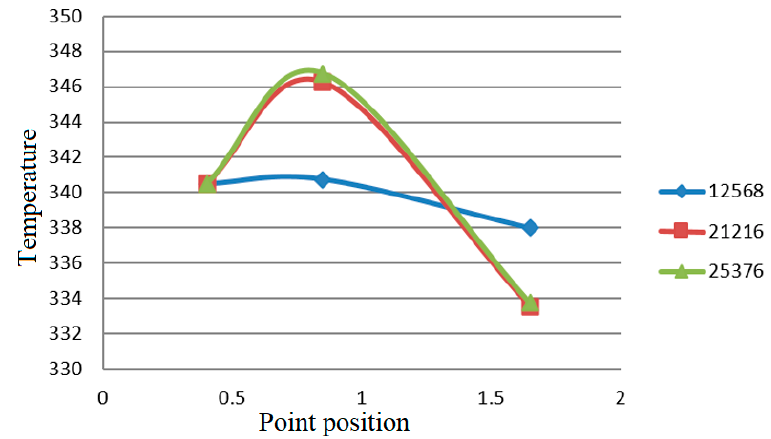
Figure 7. Mesh dependence study.